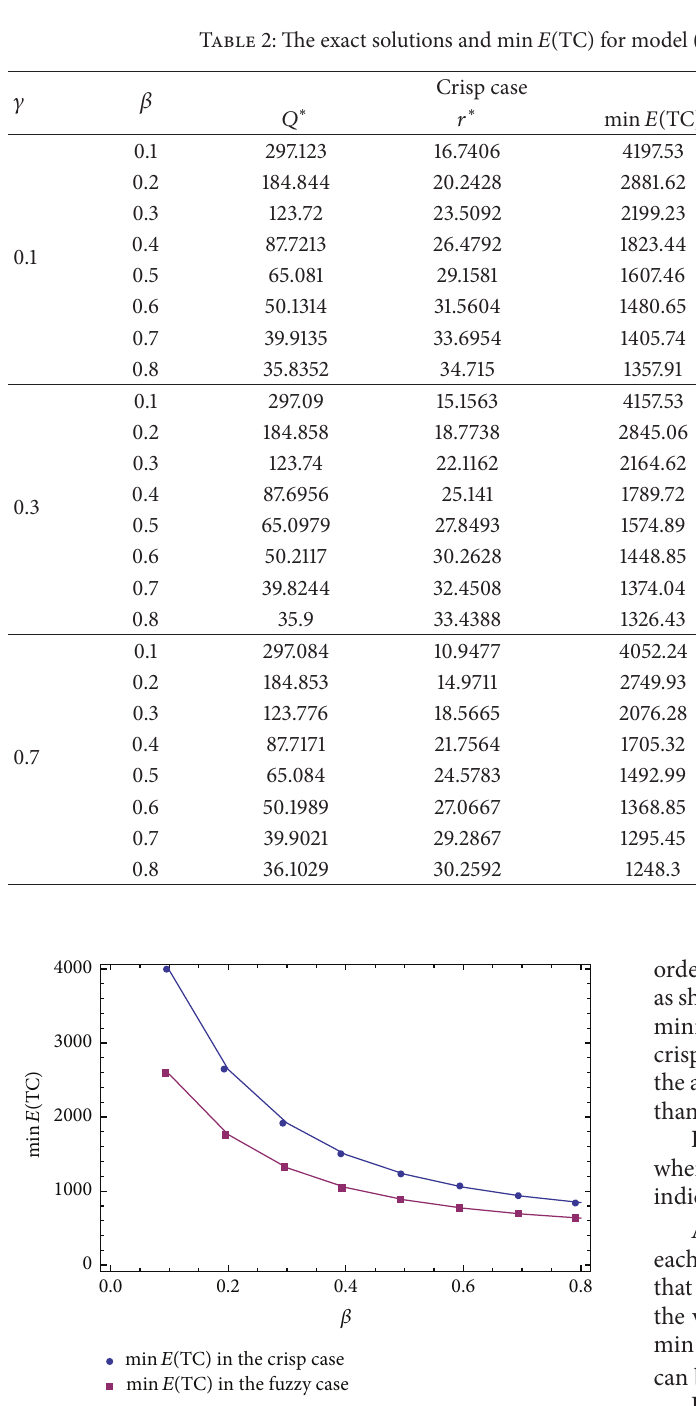
Figure 4: The comparison between the crisp and fuzzy cases for Uniform at 𝛾 = 0.7 .